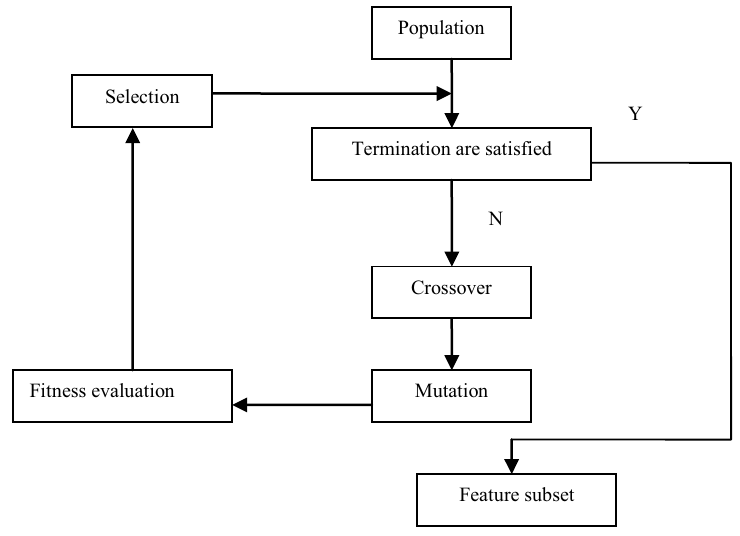
Fig.1 GA-based feature selection